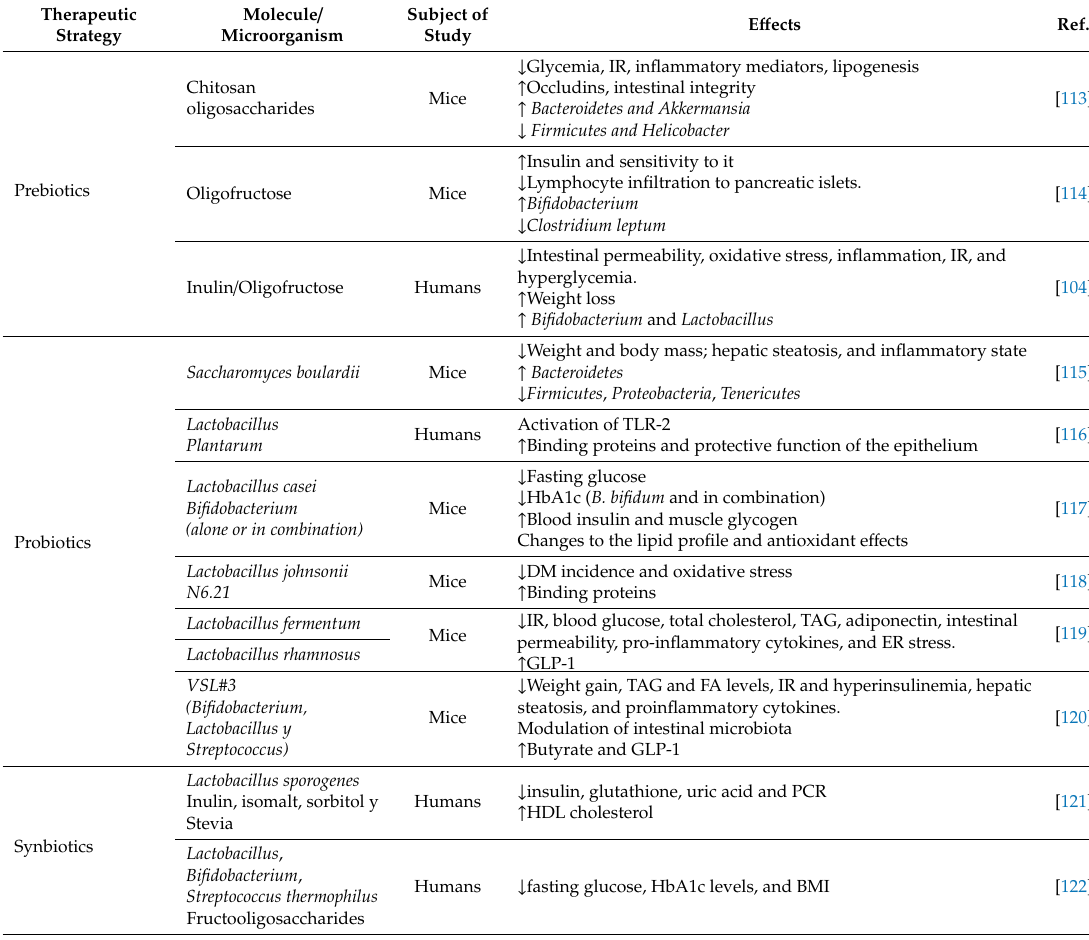
Table 1. Manipulation of gut microbiota with prebiotics, probiotics, and synbiotics for diabetes treatment and